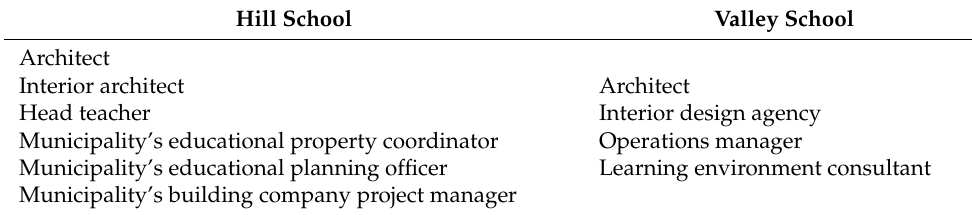
Table 2. Overview of interviews.